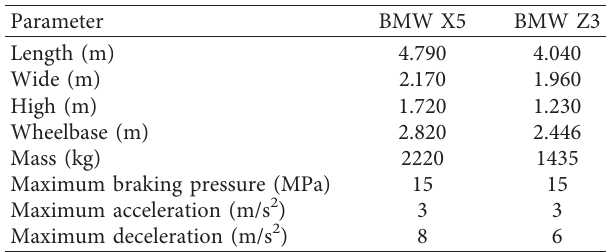
Figure 6: The simulation scenario: (a) the training and test scenario of the proposed BP-HMM model; (b) the traditional AEB model test scenario; (c) the proposed AEB model test scenario. Table 1: Main parameters of the vehicle dynamic